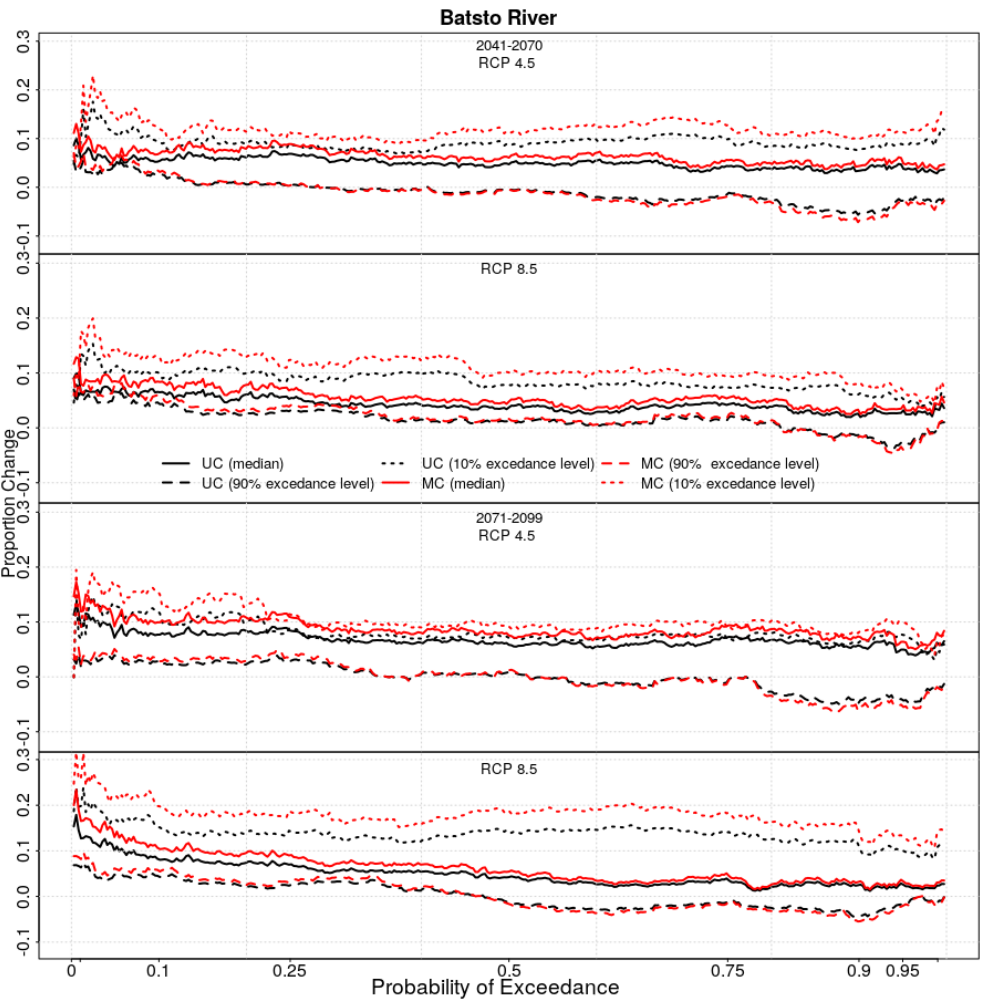
Figure 12. Projected change in stream flows as indicated by the proportional change in stream flow at each exceedance level of the FDC for the Batsto River. Projected change in flow is shown for each RCP for uncorrected (UC) and model-corrected (MC) GCM